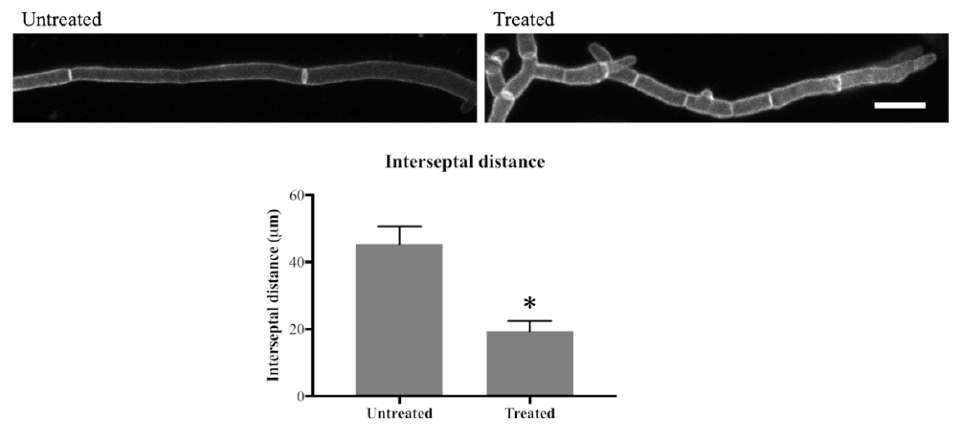
Figure 4. Olorofim treatment decreases interseptal distance indicating that septum formation is increased. Scale bar = 20 µm. Error bars represent SD. * p < 0.01 .